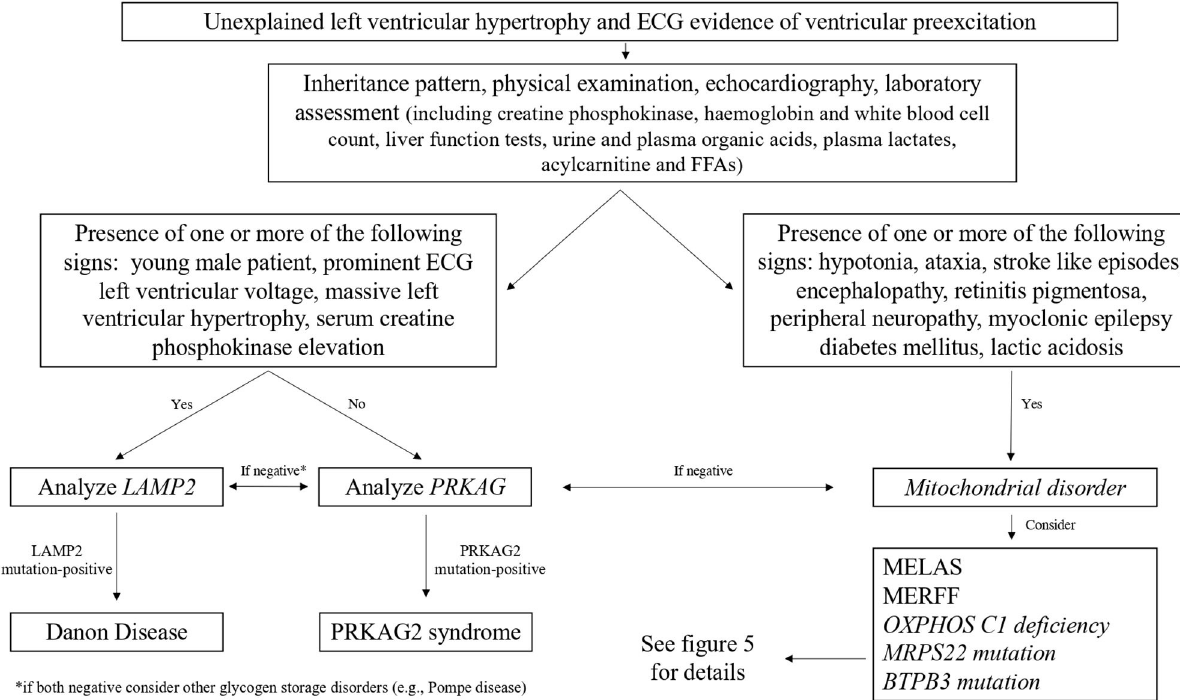
normal serum CK levels (96). Likewise, learning disabilities